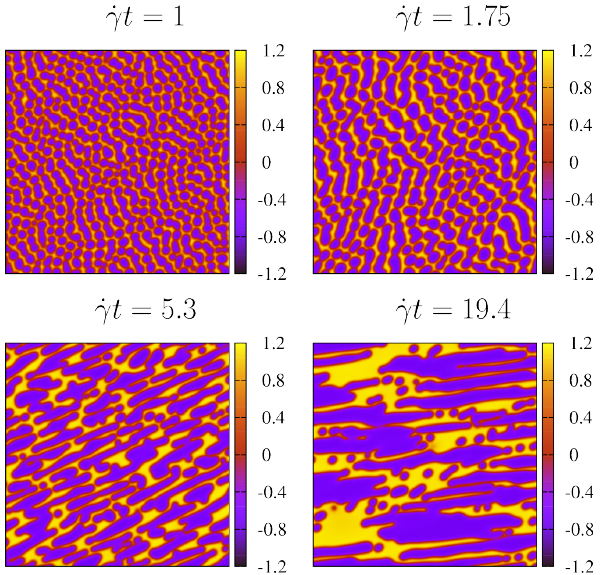
Figure 3. Configurations of the system at consecutive times in the weak shear regime ( ˙ γ t D = 1.0) with λ = 3. A central portion of size 512 × 512 of the whole lattice is shown.